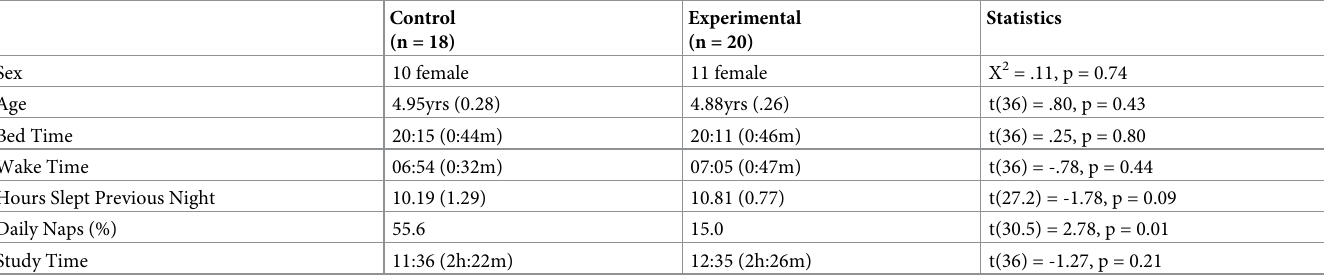
Table 2. Descriptive statistics, M(SD), for demographics, sleep habits, and study participation time.